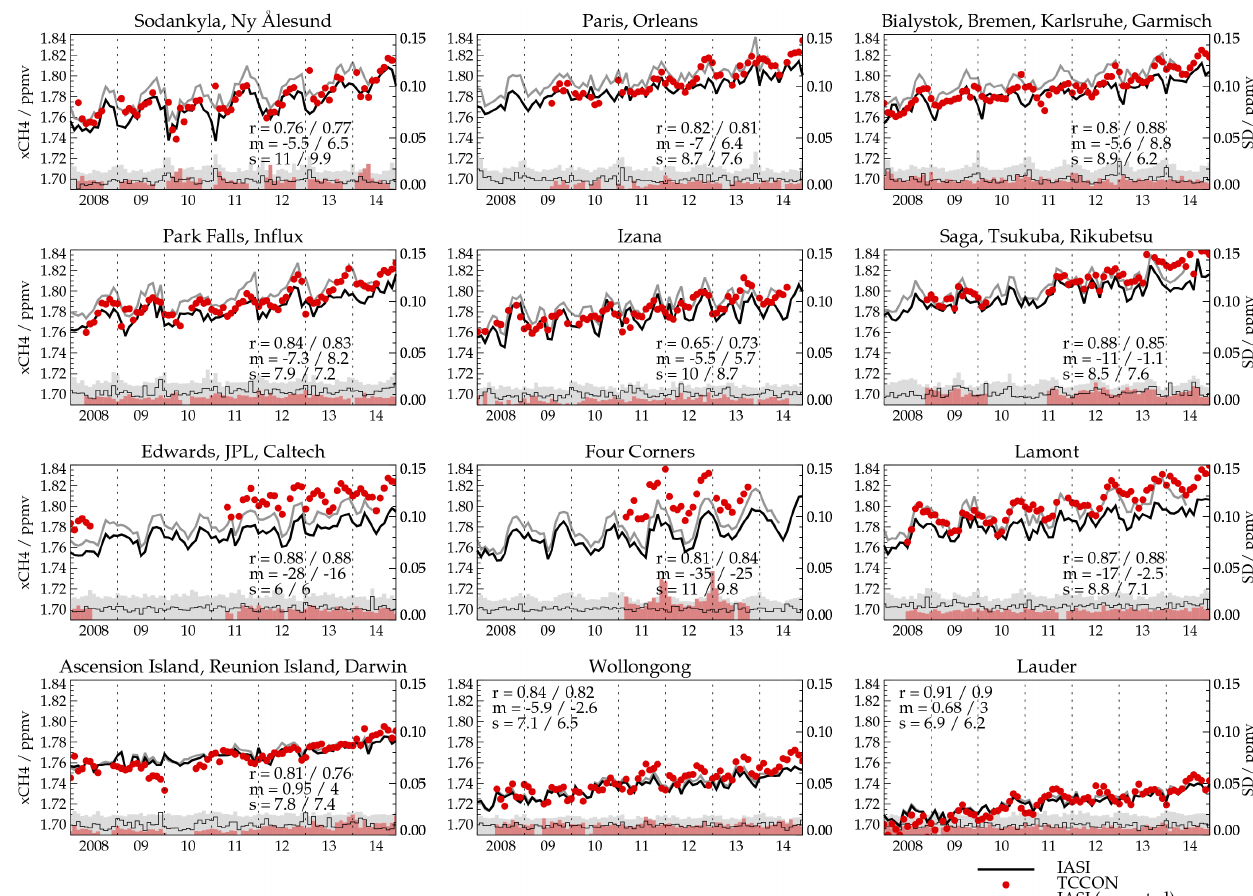
Figure 14. Comparison of IASI and TCCON monthly column-averaged methane mixing ratio from 2008 to 2014. The black line shows IASI and red points show TCCON. The grey line shows the IASI result corrected to account for the IASI smoothing error using MACC (see text). Histograms indicate the SD in the IASI and TCCON monthly mean (refer to right-hand axis). Figures in the caption indicate the correlation coefficient ( r ), mean difference ( m , in ppbv) and SD in the difference ( s , in ppbv). Two values are given for each quantity (separated by a slash), corresponding to the black (IASI direct) and grey (IASI corrected) curves,